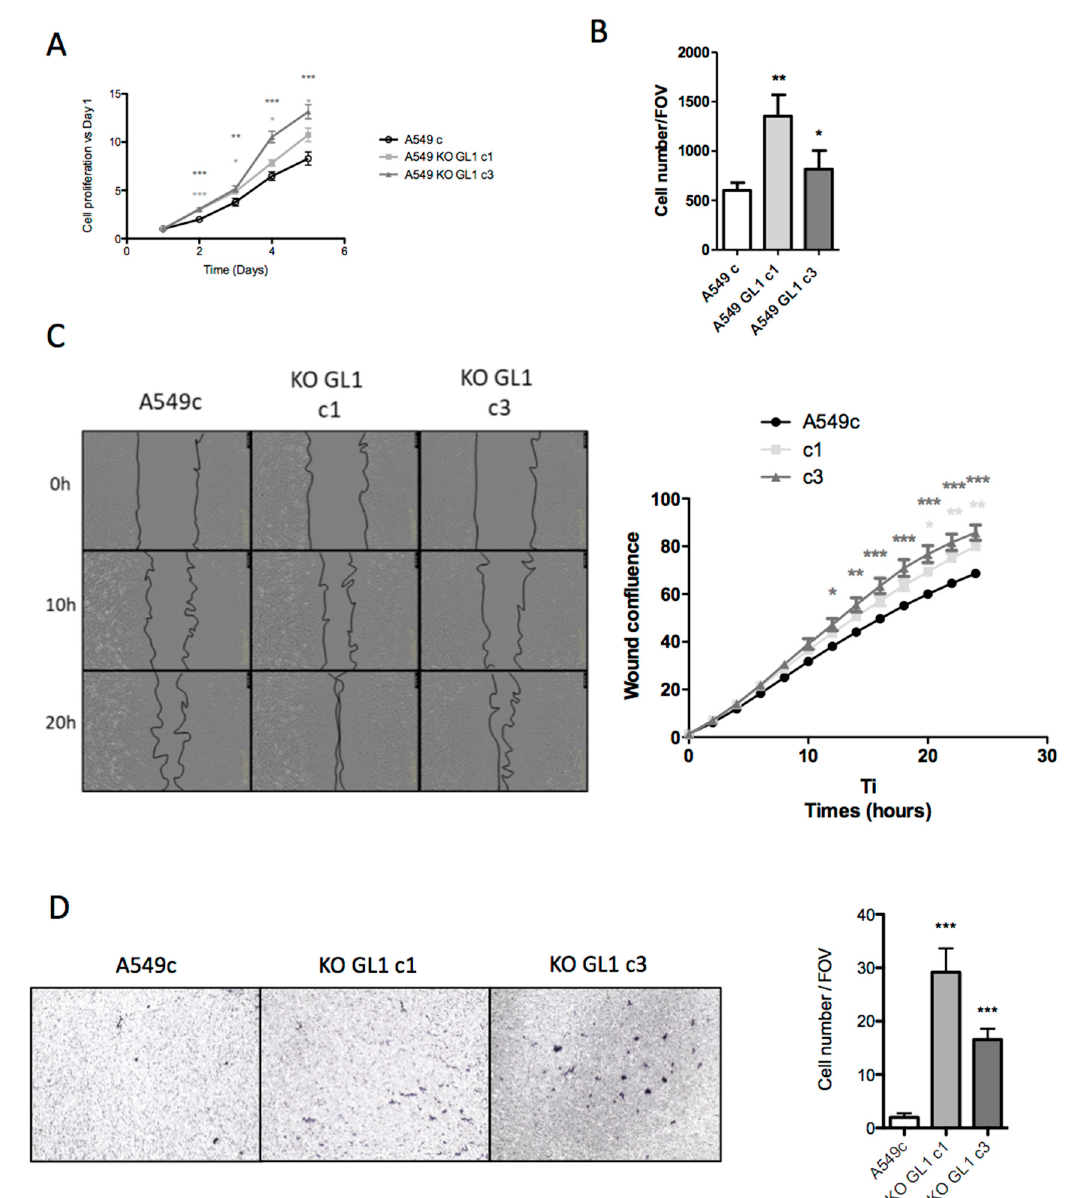
Figure 7. GABARAPL1 knockout increases cell proliferation and invasion. ( A ) Growth rate of A549c and KO GABARAPL1 cells using MTT assay. The data shown are representative of three independent experiments performed in eight replicates. ( B ) Invasion of A549c, KO GL1 c1 and KO GL1 c3 in modified Boyden chambers. Cell density was estimated via photographs taken using an EVOS XL Core microscope. ( C ) Migration rates of A549c, KO GL1 c1, and KO GL1 c3 using a scratch wound-healing assay. Cell migration was quantified by the confluence wound study using IncuCyte from 0 to 24 h. ( D ) Migration rates of A549c, KO GL1 c1, and KO GL1 c3 using modified Boyden chambers. A representative image of each membrane is shown. Six FOVs were randomly selected, and the number of cells that migrated through the membrane was determined.